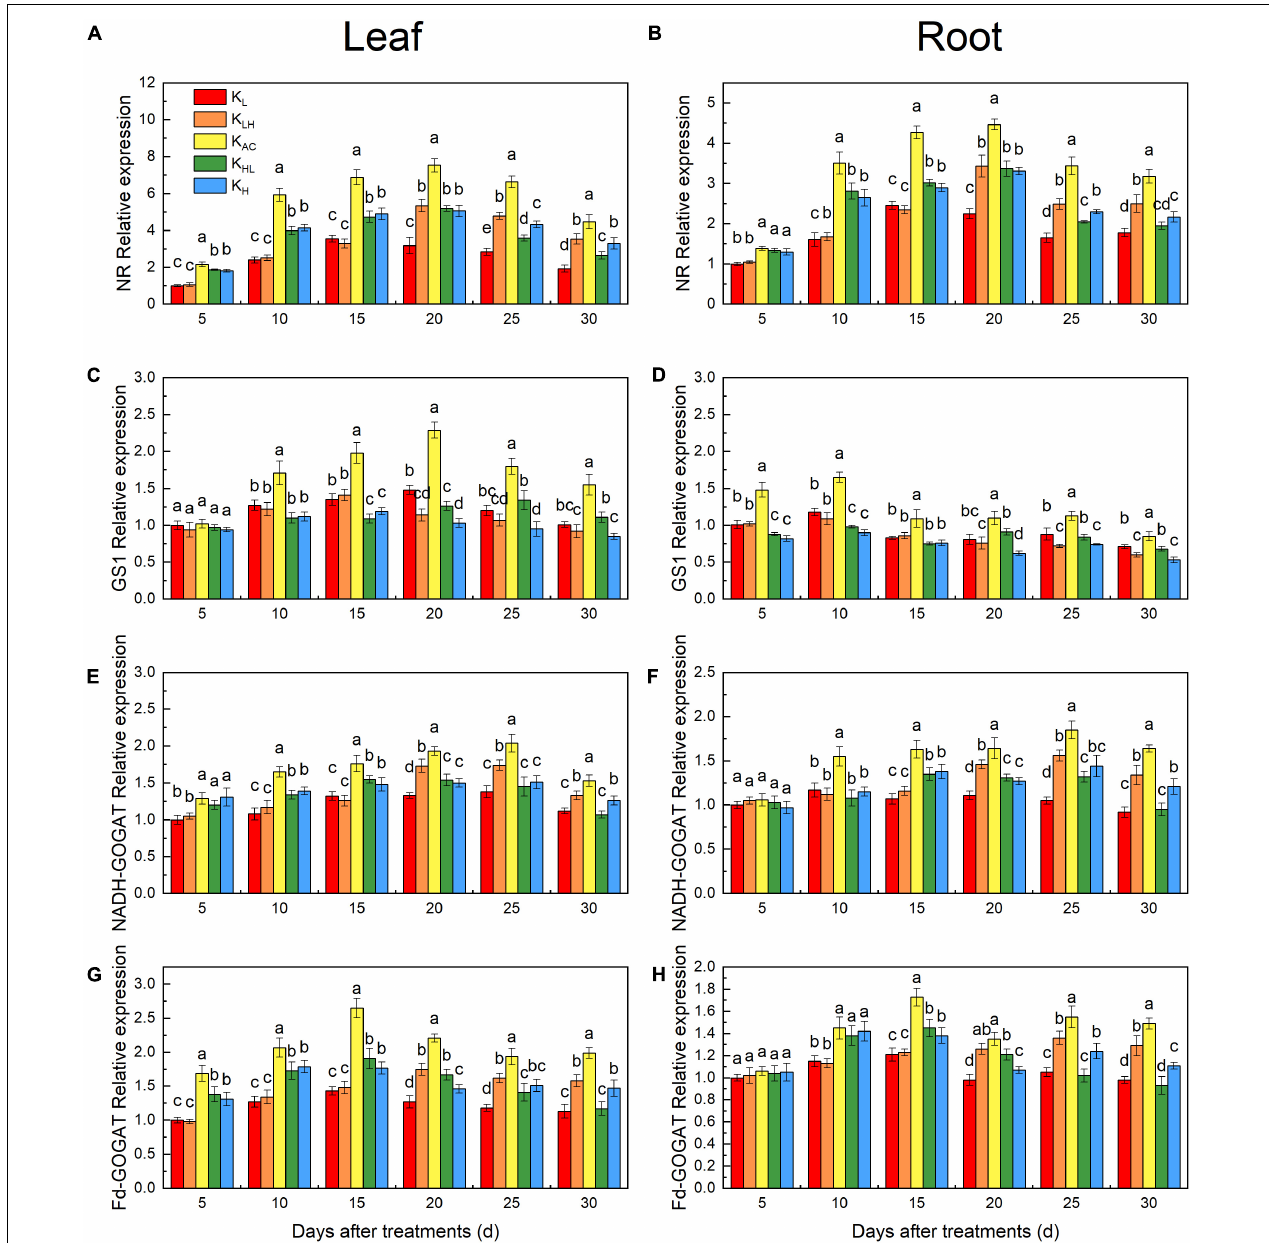
FIGURE 9 | NR relative expression in the leaves (A) and roots (B) ; GS1 relative expression in the leaves (C) and roots (D) ; NADH-GOGAT relative expression in the leaves (E) and roots (F) ; Fd-GOGAT relative expression in the leaves (G) and roots (H) of M9T337 rootstocks treated with different K treatments. Data show the means ± standard deviation of three independent samples. Different letters on vertical bars indicate significant differences ( P <